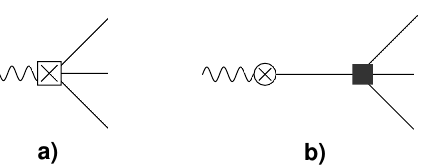
Figure 2 . New diagrams due to the short-distance explanation, see the text. The vertices from The straight lines are pions and the wavy ones correspond to the incoming W −